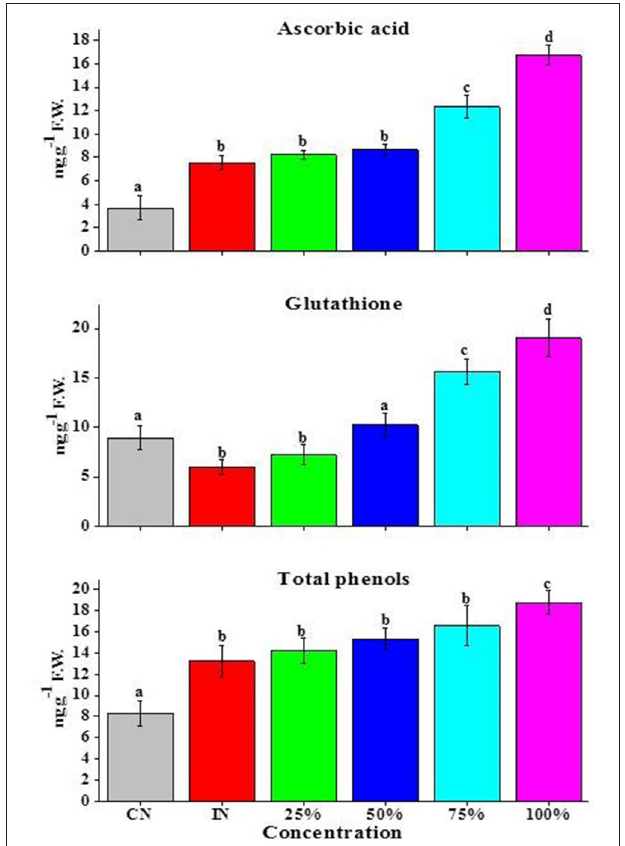
FIGURE 4 | Effects of Z. armatum DC EO on endogenous titers (mg g − 1 FW) of antioxidants (ASA, GSH, and TPC) of tomato fruits inoculated with A. alternata . CN, control; IN, inoculated; 25, 50, 75, and 100% indicate concentrations of EO used. Values represent mean ± standard error, where number of biological repeats is five ( n = 5). Different letters (a–d) indicate significant differences from each other in all combinations at p < 0.05.